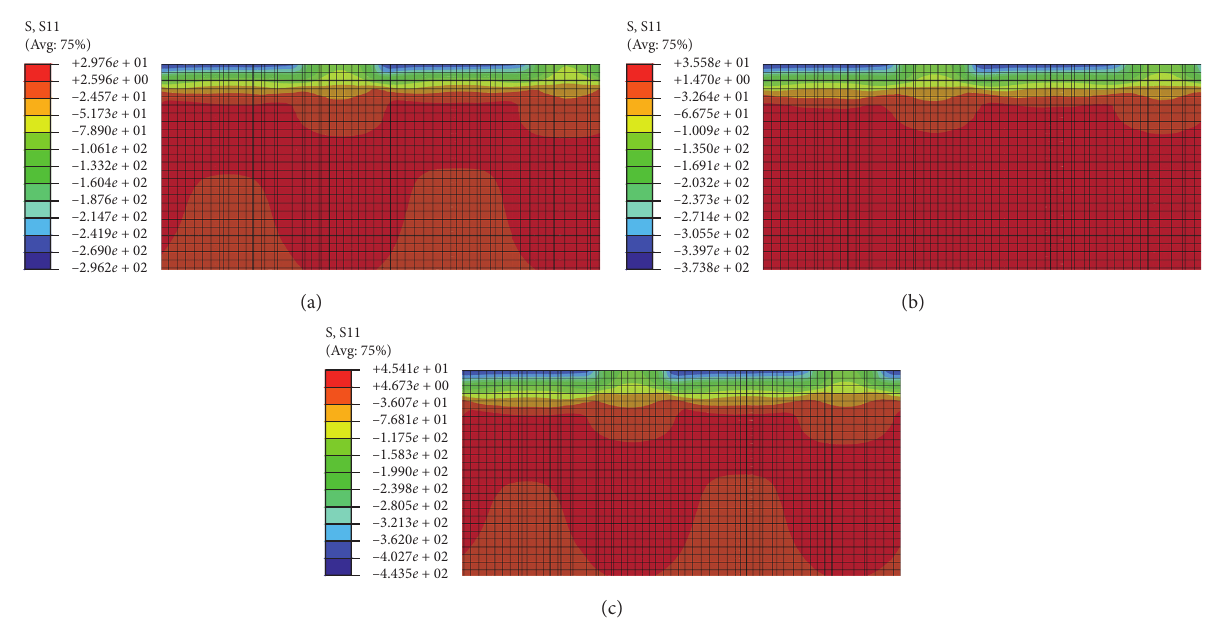
Figure 8: Contours of residual stress distribution in-depth direction of sample surface with different laser power. (a) 5J, (b) 6J, and (c) 7J.